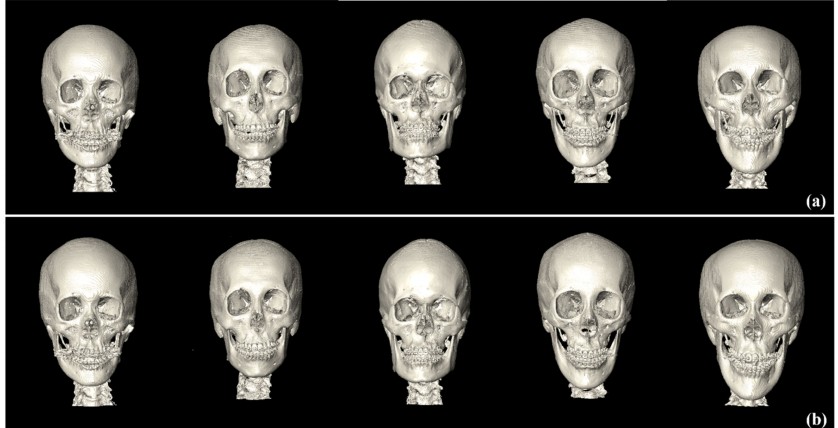
Figure 7. Patient CT head models shown before NHP reproduction ( a ) and after NHP reproduction ( b ) for patients with severe and mild facial